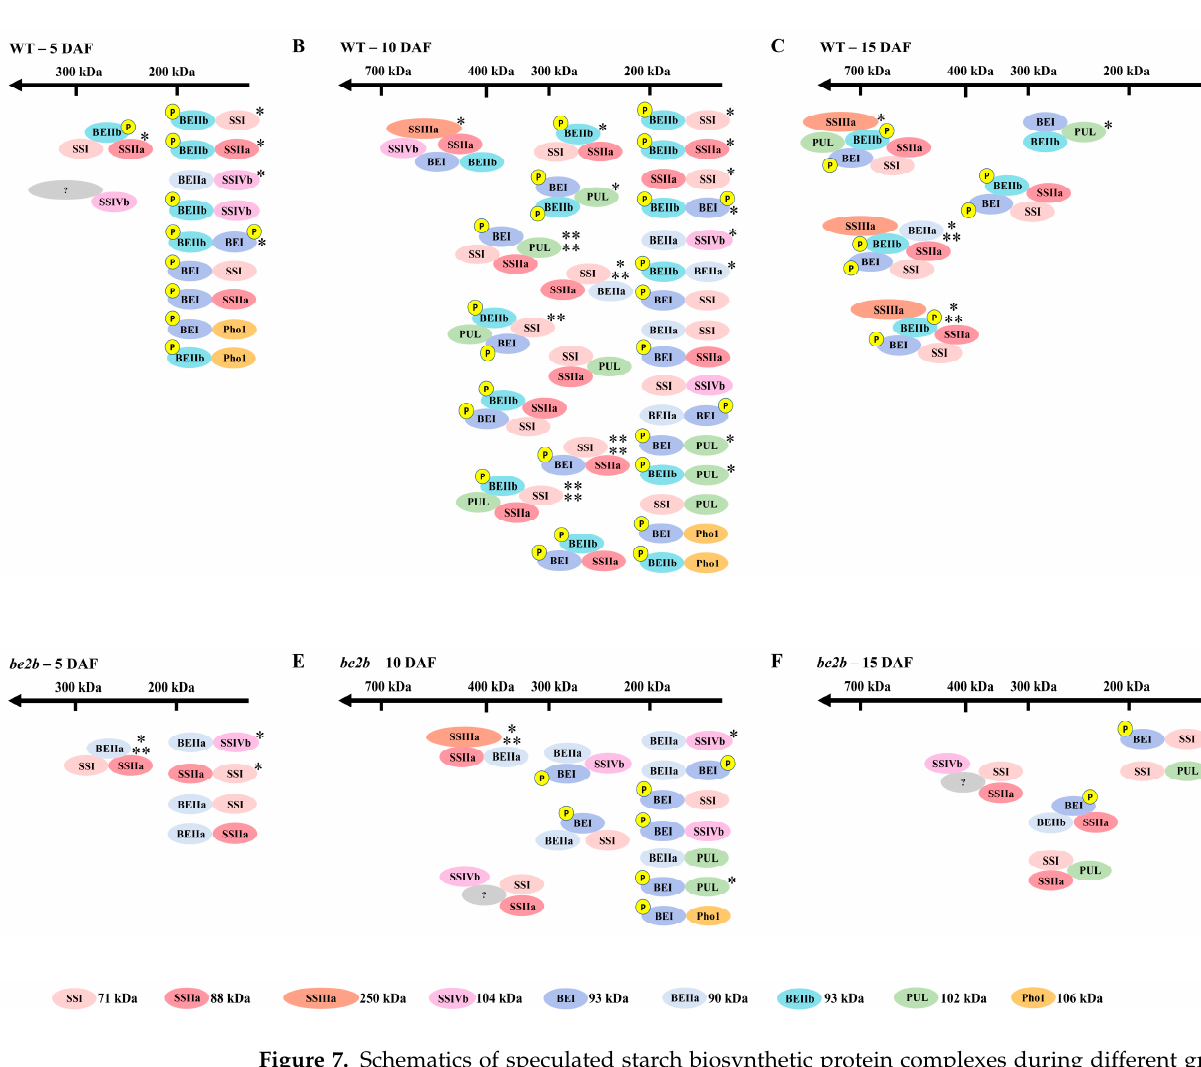
Figure 7. Schematics of speculated starch biosynthetic protein complexes during different grain- filling stages (5 DAF, 10 DAF, 15 DAF) in wild type (WT) and be2b mutant: ( A ) WT–5 DAF; ( B ) WT–10 DAF; ( C ) WT–15 DAF; ( D ) be2b –5 DAF; ( E ) be2b –10 DAF; ( F ) be2b –15 DAF. SS isozymes are in red, BE isozymes are in blue, DBE isozymes are in green, Pho1 is in yellow, and phosphate groups are indicated in a small circle. Single, double, triple, and quadruple asterisks indicate the formation of protein complexes confirmed in this study, previously reported by Crofts, et al. [29], Chen and Bao [43], Crofts, et al. [30], and Chen, et al. [44], respectively. Monomeric molecular weights of each isozyme are indicated at the bottom. Note that the schematics do not intend to imply specific details of stoichiometry or direct contacts within the complexes since both direct and indirect physical in- teractions could be detected by co-immunoprecipitation.